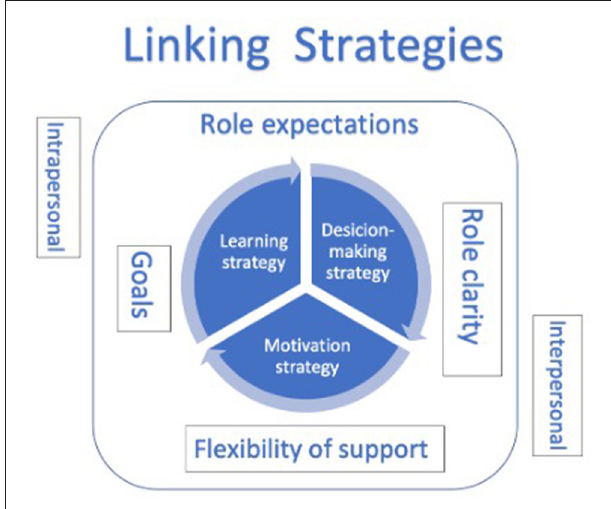
FIGURE 1 | Strategic elements which contribute to facilitating shared understanding between players on and off the pitch in coordinating actions to handle challenging situations as a